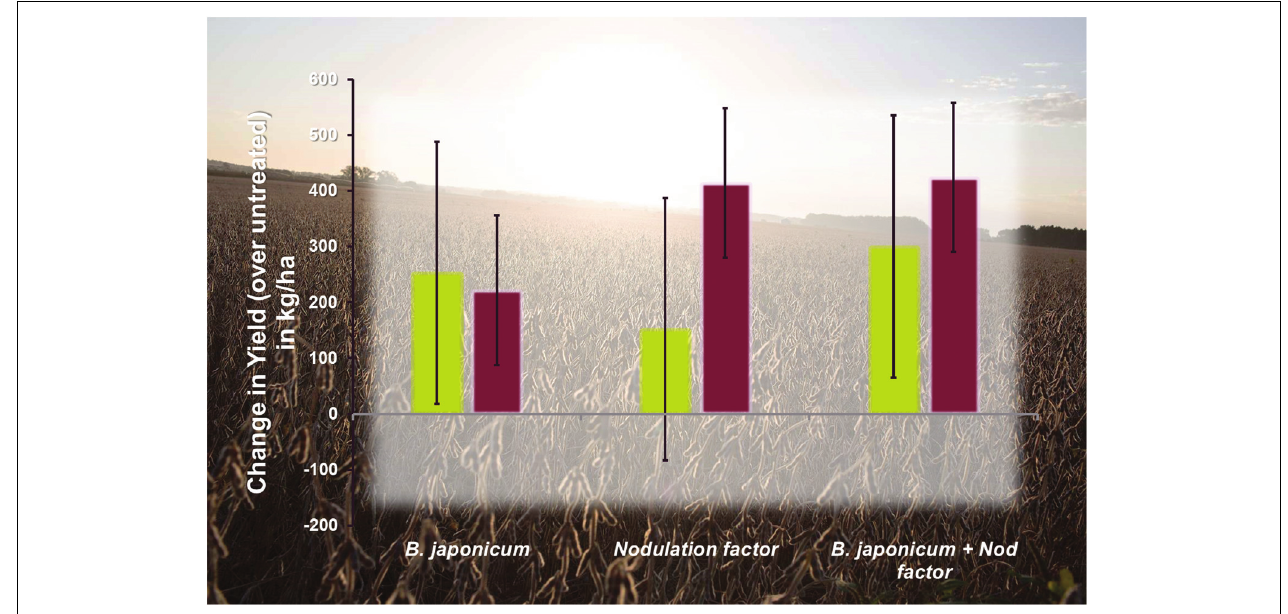
FIGURE 1 | Performance of Bradyrhizobium japonicum , a nodulating factor (LCO), and the combination of B. japonicum and nodulating factor (Optimize R (cid:13) ) in field trials. Field trials occurred in pristine soil (no previous soy; violet), and soils with previous soy crops (green). Error bars represent least significant difference at 95% (adapted from Smith et al., 2015).